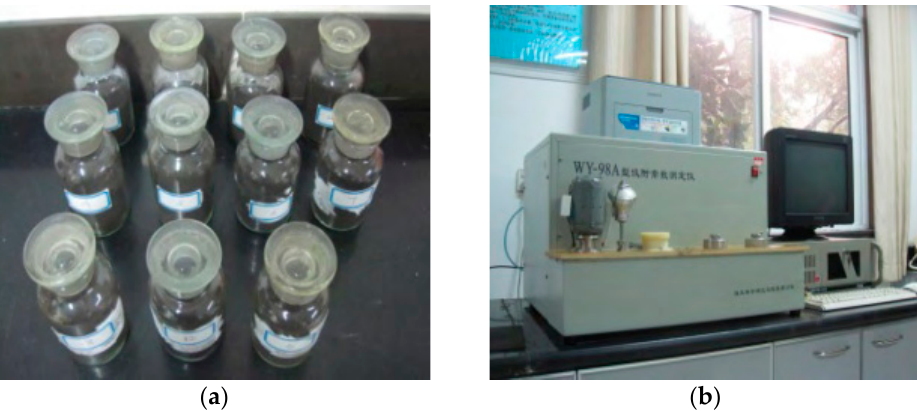
Figure 4. Adsorption tests of the similar material. ( a ) Specimens in the adsorption tests; ( b ) the tester of the adsorption constant.